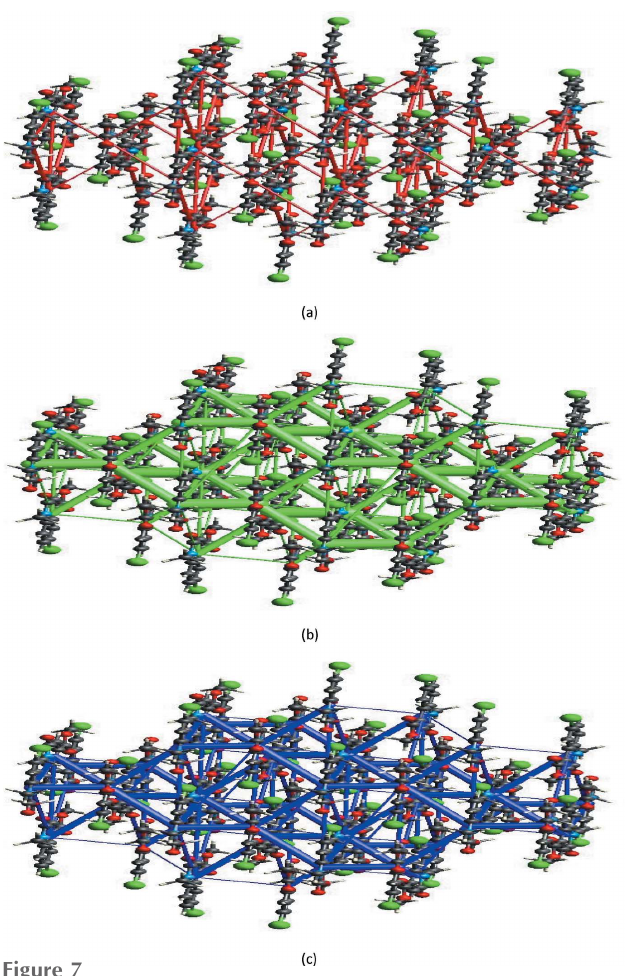
Figure 7 Energy frameworks of (I).